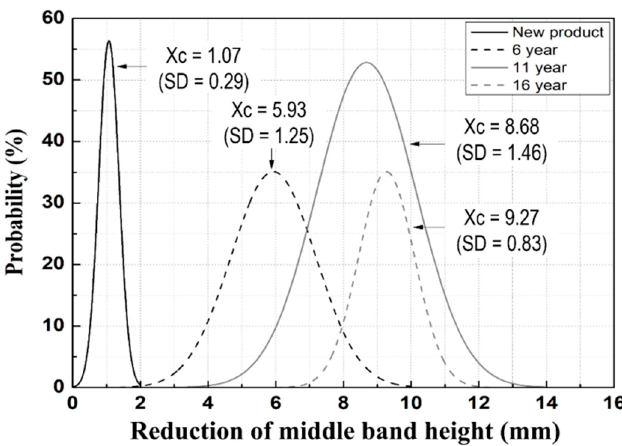
Figure 8. Reduction in the middle-band height of tension clamps.